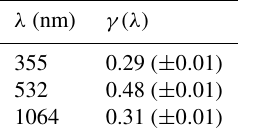
Table 2. Overview of the fitting parameter of the LR( λ) enhance- ment factor. The standard error of fit is marked with